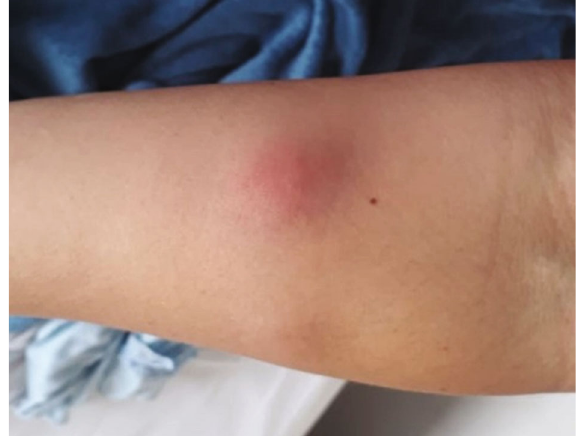
Figure 7: Skin rash 1 day after treatment with spontaneous regression.